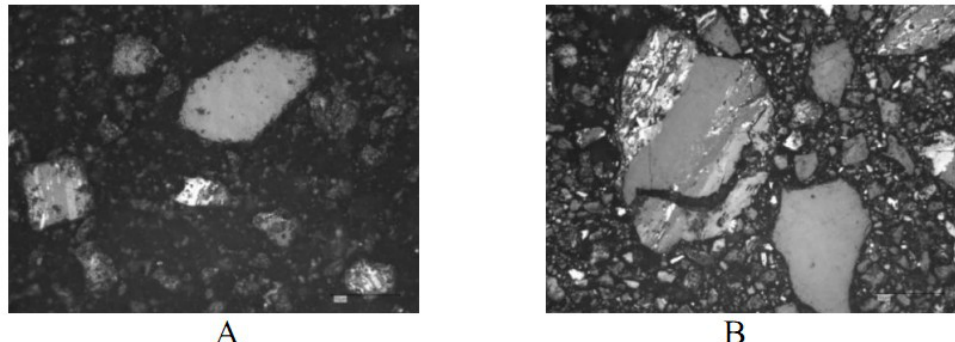
Fig. 1. The petrographic photographs of polished coal samples of Tavan tolgoi deposit: Photograph of coal from borehole IV; B- photograph of coal from borehole VIII.